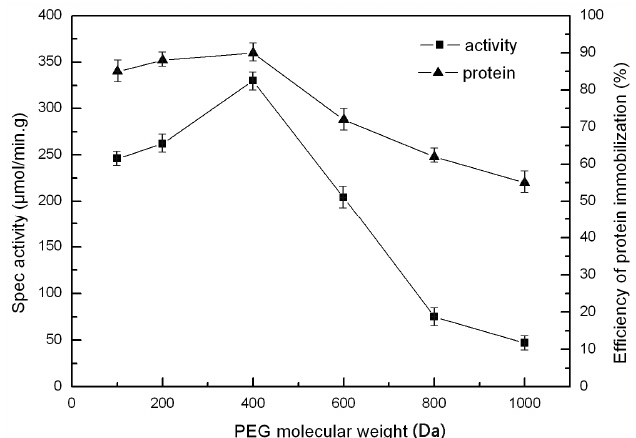
Figure 3. The effect of the molecular weight of PEG. MTMS/TMOS molar ratio of 5:1, water/silane molar ratio of 12, 120 mg of enzyme supply, 60 mg of SiO 2 .